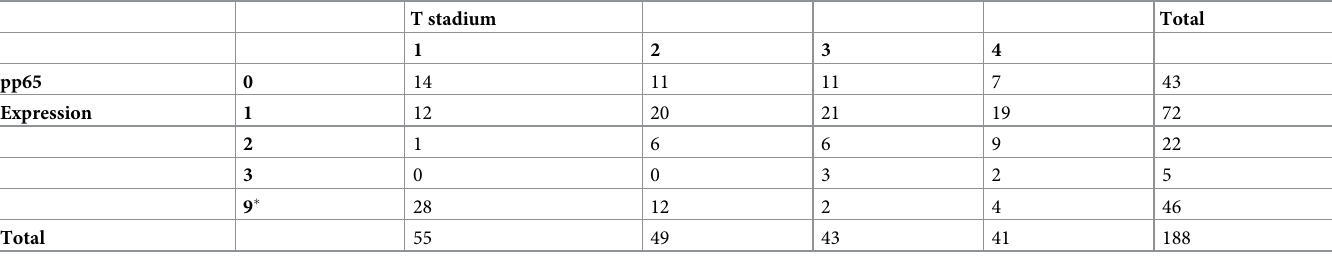
Table 1. CMV pp65 immunoreactivity vs T-stadium in